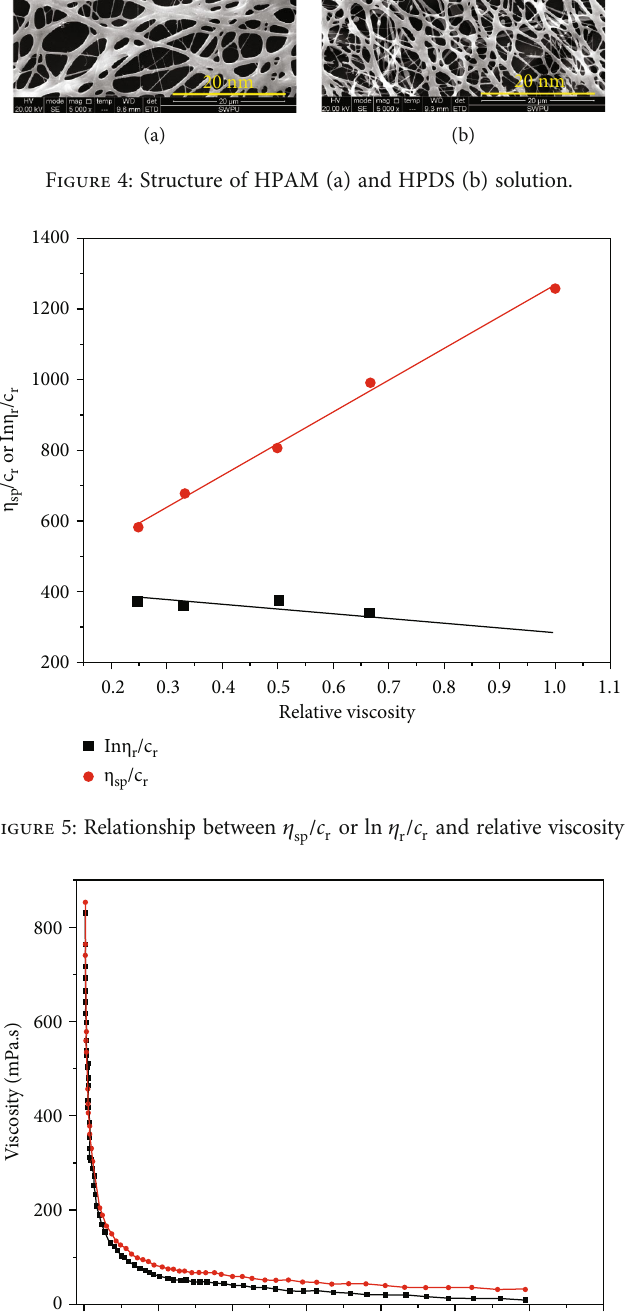
Figure 6: Relationship between apparent viscosity and shear